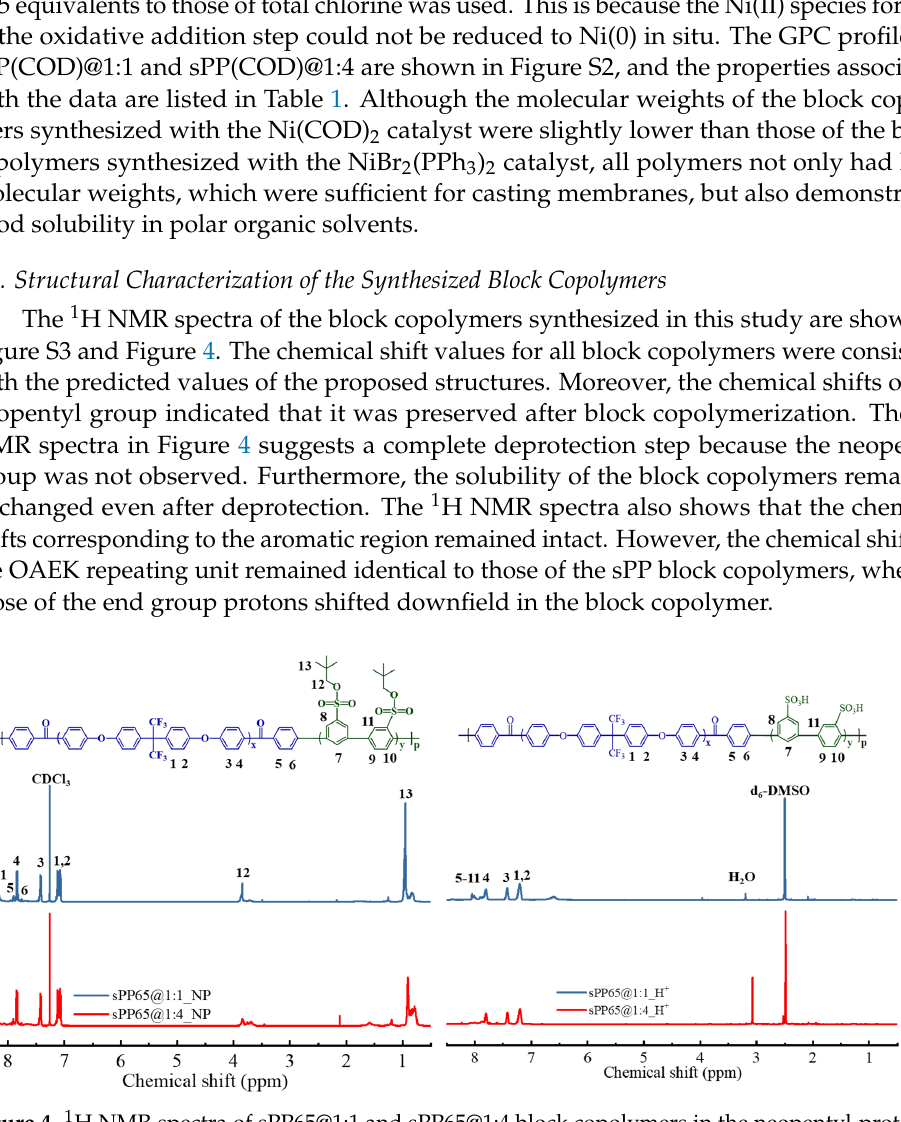
Figure 4. 1 H NMR spectra of sPP65@1:1 and sPP65@1:4 block copolymers in the neopentyl-protected and protonated forms recorded in CDCl 3 and d 6 ‐ DMSO, respectively.